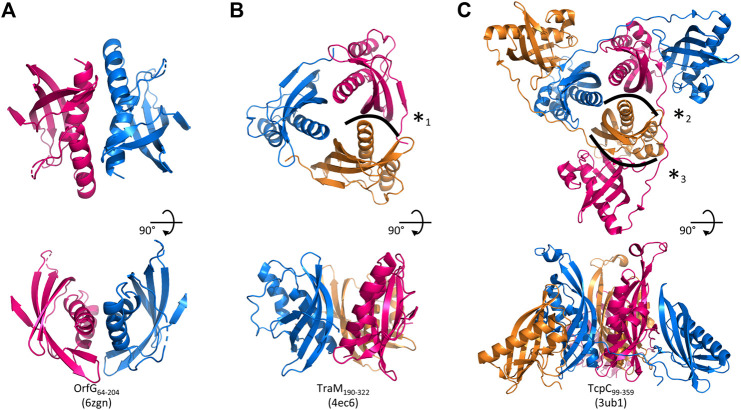
Assemblies of Gram-positive VirB8-like proteins observed in the crystals. A crystallographic 2-fold axis relates two monomers of OrfG64–204 (PDB id 6zgn) (A), while TraM190–322 (4ec6) (B) and TcpC99–359 (3ub1) (C) form trimers. Each assembly is shown perpendicular (top) and parallel (bottom) to its symmetry axis. The interface with the highest surface area, here represented for OrfG64–204, is resolutely rejected by PISA (Krissinel and Henrick, 2007). The interface (*1) in TraM190–322 extends on ∼300 Å2 and involves two to nine hydrogen bonds or salt bridges depending on the observed monomer (as calculated by PISA for residues 214 to 318 of 4ec6). The equivalent interface in TcpC99–359 (*2) represents ∼430 Å2 (PISA on residues 104–228 of 3ub1) and six to nine hydrogen bonds or salt bridge depending on the monomer. It is by far slighter than the interface (*3) observed between the central domain (TcpC104–231) of one monomer and the C-terminal domain (TcpC239–359) of a second one, which extends on ∼980 Å2 and involves 13–14 hydrogen bonds or salt bridges depending on the observed monomer. The structure-based sequence alignment of OrfG, TcpC and TraM available in Figure 6 shows residues involved in these interactions.